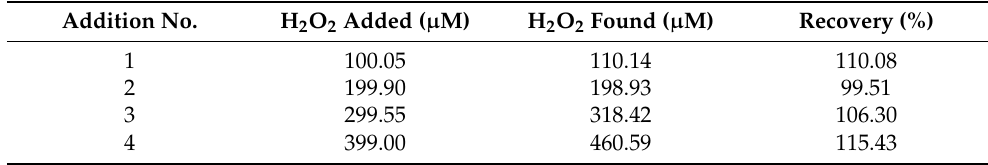
Table 3. Determination of H 2 O 2 in Apple Juice.